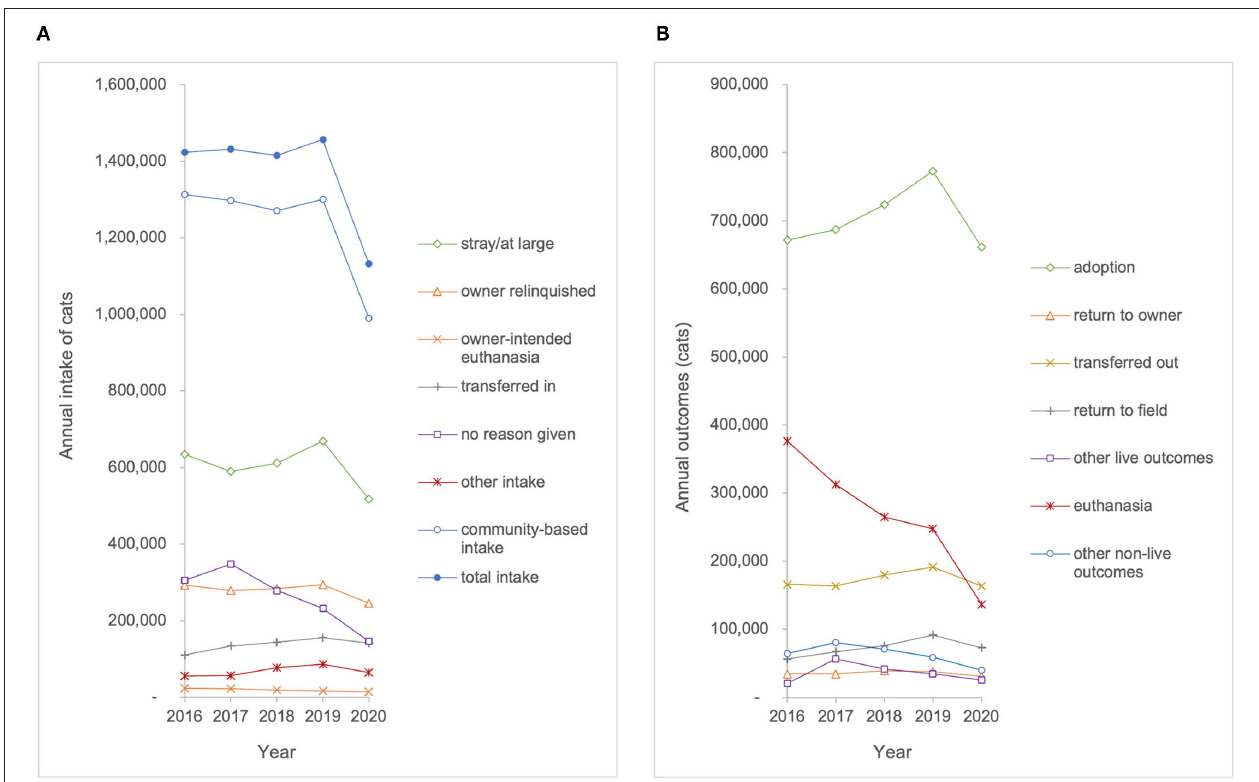
FIGURE 3 | (A) Annual intake and (B) annual outcomes for cats entering the shelters in the sample population ( n = 1,101) from 2016 to 2020.